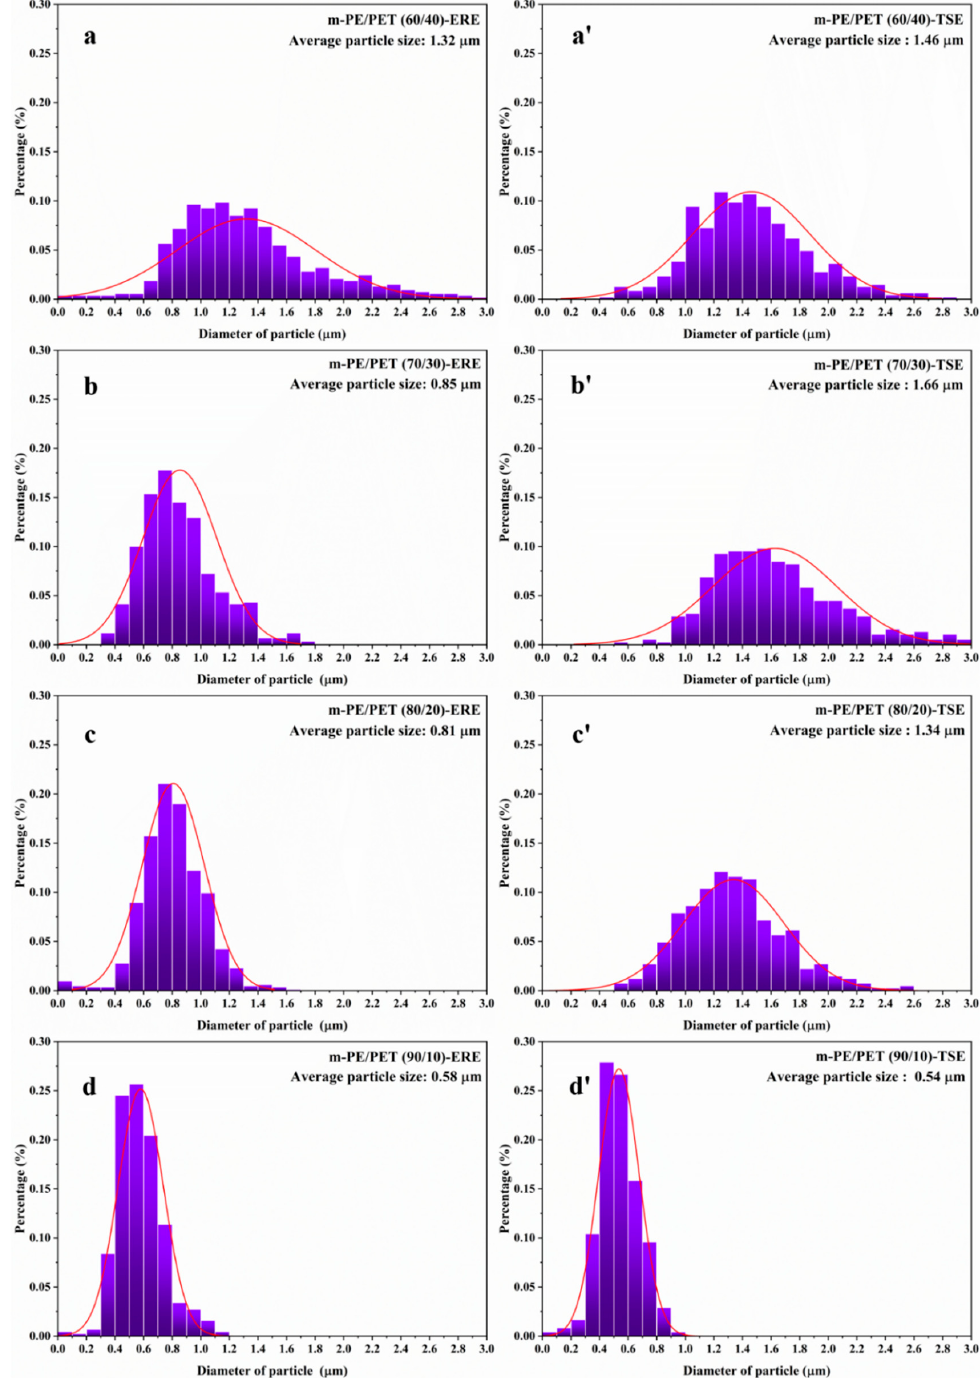
Figure 3. Statistics of the particle size and the size distribution of m-PE / PET blends processed using TSE and ERE, respectively. ERE processed blends: ( a ) m-PE / PET 60 / 40; ( b ) m-PE / PET 70 / 30; ( c ) m-PE / PET 80 / 20; ( d ) m-PE / PET 90 / 10. TSE processed blends: ( a’ ) m-PE / PET 60 / 40; ( b’ ) m-PE / PET 70 / 30; ( c’ ) m-PE / PET 80 / 20; ( d’ ) m-PE / PET 90 /